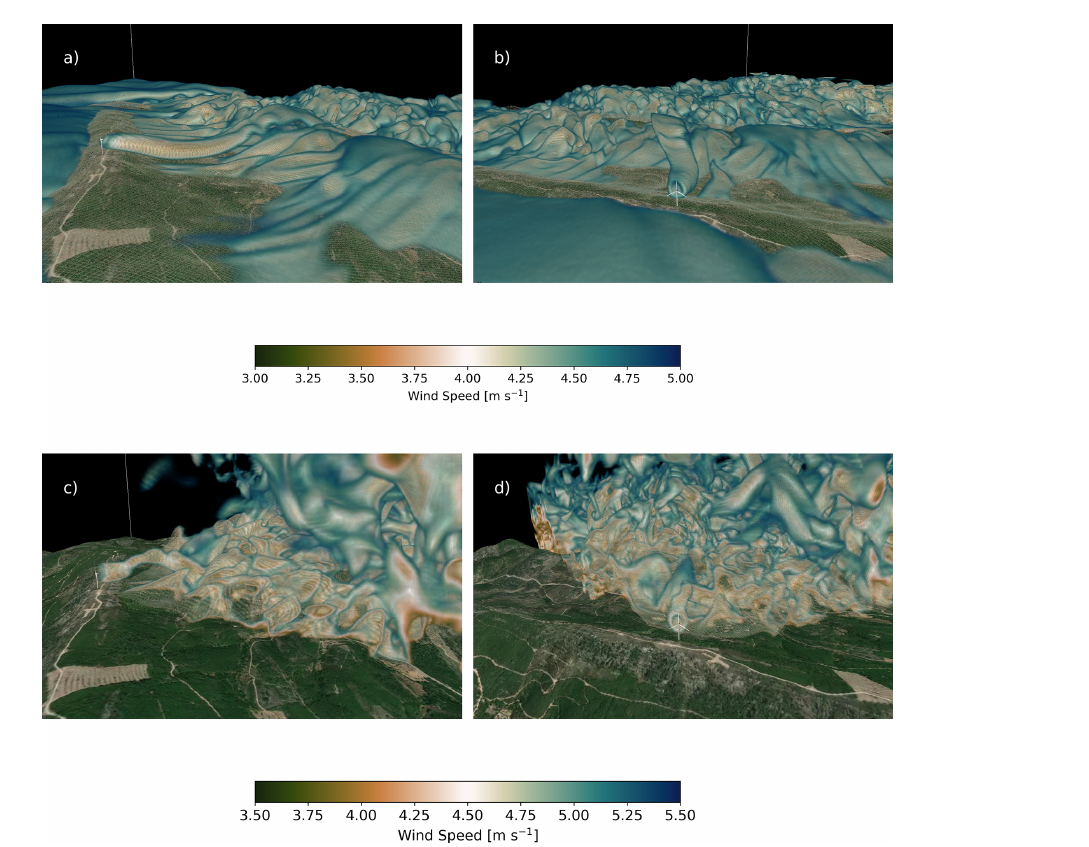
Figure 12. Three-dimensional volume rendering of wind speed for the stable case at 04:37:30UTC (a,b) and for the convective case at 13:33:20UTC (c,d) . For the stable case, only wind speeds between 3.0 and 5.0ms − 1 are shown, and the wind speeds at the first five vertical levels have been removed for clarity. For the convective case, only wind speeds between 3.5 and 5.5ms − 1 are shown, and data to the south and west of the turbine have been removed for clarity. The viewpoint in panels (a) and (c) is from the southeast looking down the valley to the northwest. The viewpoint in panels (b) and (d) is southwest of the wind turbine looking to the northeast. Visualization made using VAPOR (Clyne et al.,